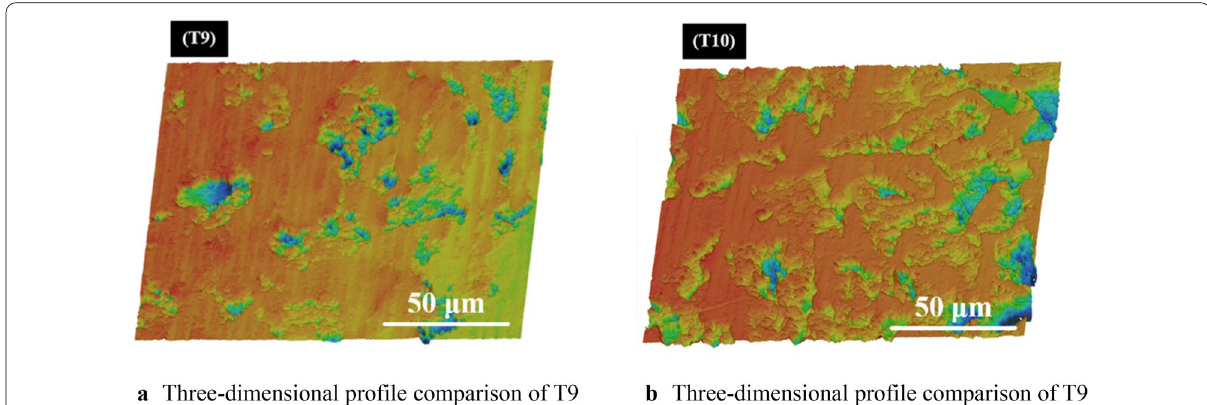
Figure 4 Three-dimensional profile comparison of T9 and T10